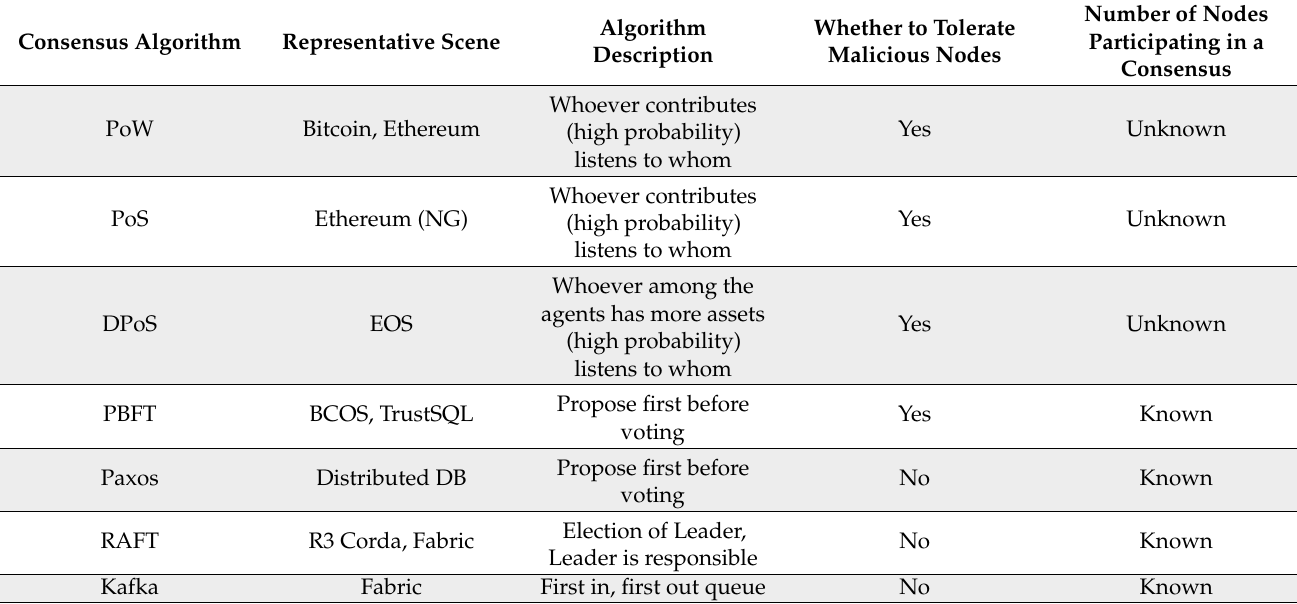
Table 2. Consensus Algorithm application scenarios and